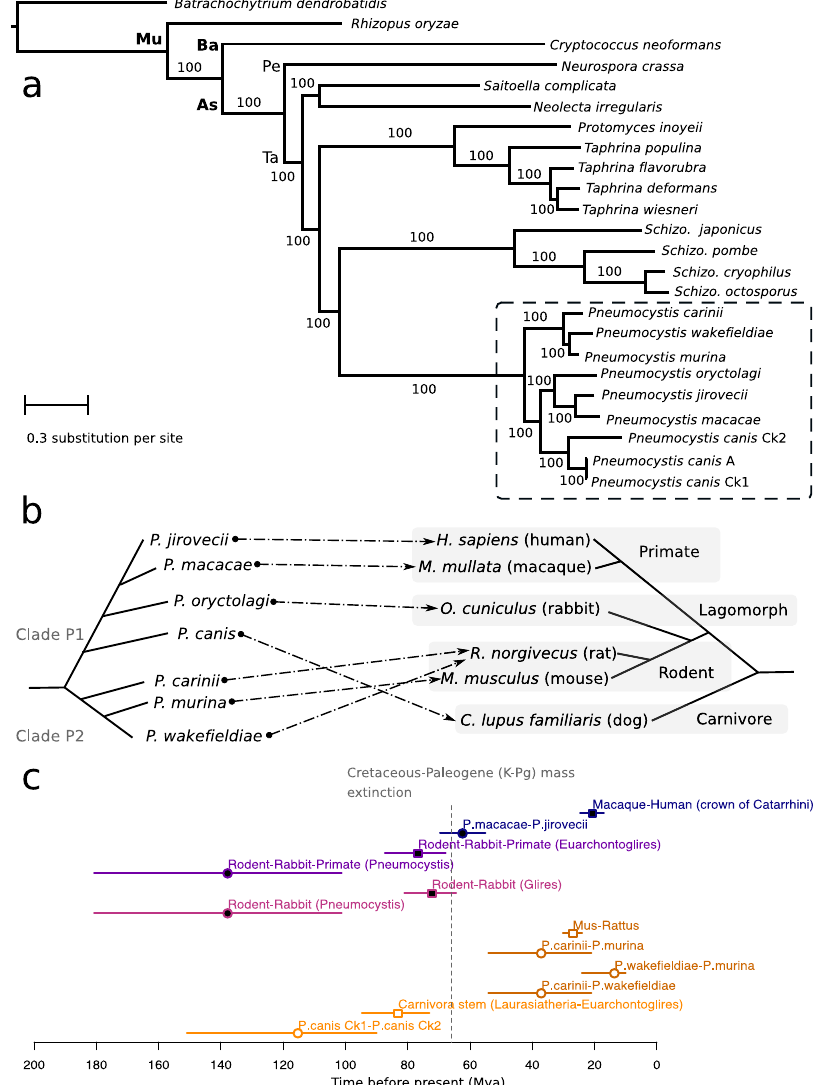
Fig. 2 Phylogeny and divergence times of Pneumocystis species. a Maximum likelihood phylogeny constructed using 106 single-copy genes based on 1000 replicates from 24 annotated fungal genome assemblies including nine from Pneumocystis (highlighted with a dashed box). Only one assembly is shown for each species except there are three for P. canis (assemblies Ck1, Ck2, and A). Bootstrap support (%) is presented on the branches. The fungal major phylogenetic phyla and subphyla are represented by their initials: As (Ascomycota), Ba (Basidiomycota), Pe (Pezizomycotina), Mu (Mucoromycota), and Ta (Taphrinomycotina). b Schematic representation of species phylogeny and association between Pneumocystis species and their respective mammalian hosts. The dashed arrows represent the speci fi c parasite-host relationships. c Divergence times of Pneumocystis species and mammals ( n = 12 taxonomic clades analyzed). Divergence time medians are represented as squares for hosts and as circles for Pneumocystis , and the horizontal lines represent the 95% con fi dence interval (CI) error bars, which are color-coded the same for each Pneumocystis and its host. Closed elements represent nodes that are different in term of divergence times (nonoverlapping con fi dence intervals) whereas open elements represent nodes with overlapping con fi dence intervals. Catarrhini, taxonomic category (parvorder) including humans, great apes, gibbons, and Old-World monkeys. Euarchontoglires, superorder of mammals including rodents, lagomorphs, treeshrews, colugos, and primates. Glires, taxonomic clade consisting of rodents and lagomorphs. Laurasiatheria, taxonomic clade of placental mammals that includes shrews, whales, bats, and carnivorans. Mya, million years ago. K-Pg, Cretaceous-Paleogene. The dotted vertical line representing the K-Pg mass extinction event at 66 mya is included for context